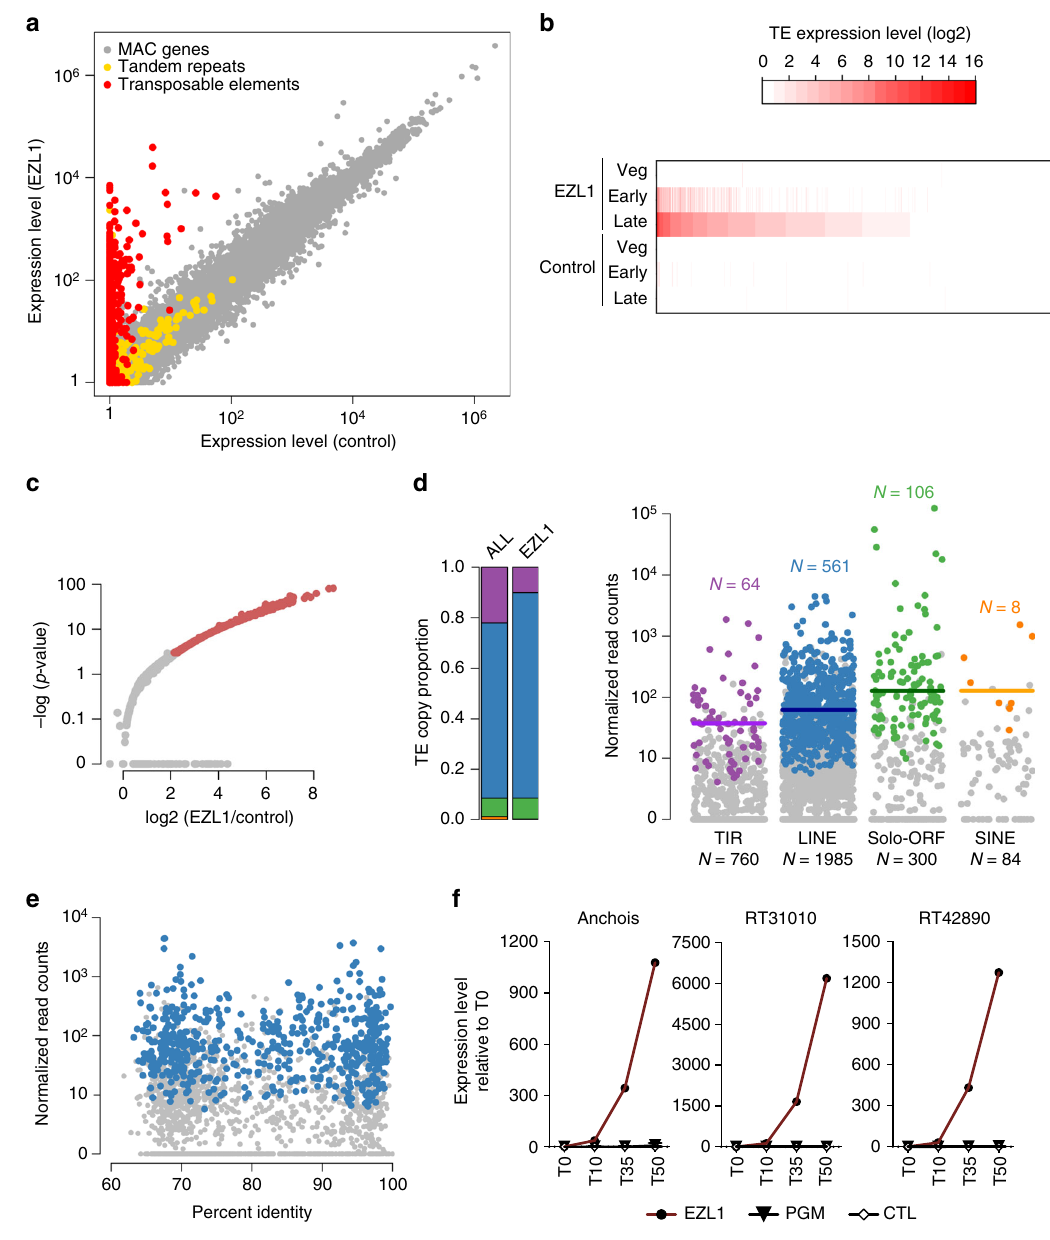
Fig. 4 Loss of H3K27me3 and H3K9me3 leads to transcriptional derepression of transposable elements. a Scatter plot of the mean normalized expression level as measured by RNA-seq for EZL1 and control samples of all elements ( n = 45,682; 41,533 genes in gray, 3129 TE copies in red, 1020 tandem repeats in yellow). The non-essential ICL7 gene was used as a RNAi control, because its silencing has no effect on sexual processes. b Heatmap of expression changes for TE copies at the three stages of the autogamy time-course (Veg, vegetative; Early; Late) in EZL1 RNAi and ICL7 (control) RNAi, ordered by EZL1 Late expression level. c Volcano plot of TE copy expression ( n = 3129) between EZL1 and ICL7 RNAi for the late stage. Red dots indicate signi fi cantly misregulation of 739 (23%) TE copies between EZL1 and ICL7 (control) RNAi (fold-change> 2 and p -value < 0.05). d Left, barplot showing the proportion of each TE family (TIR, purple; LINE, blue; solo-ORF, green; SINE, yellow) in all annotated TEs (ALL) and in the set of TEs whose expression is de-repressed upon EZL1 RNAi (EZL1). Right, expression of individual elements from four different TE families for the late developmental stage. Each dot represents a single element. The differentially expressed copies are shown in the same colors used for the barplot. The horizontal bar represents the median expression level of the differentially expressed copies. The total number of copies in each family is indicated below and the number of differentially expressed copies for each family above the jitter plots. e Scatter plot for the 1985 LINE copies, showing the relation between identity with the TE consensus and EZL1 expression level. Blue dots indicate the 561 differentially expressed LINE copies. f Expression of Anchois (TIR); RT31010 (LINE) and RT42890 (LINE) transposable elements at different time-points during development (T0; T10; T35; T50) upon PGM , EZL1 , or control ( ICL7 ) RNAi as measured by RT-qPCR. Values were normalized to GAPDH and are expressed as the fold-change to T0 (corresponds to the onset of sexual events) for each autogamy time-course experiment. Data represent the mean expression from two biological replicates for PGM RNAi. Data source are provided as a Source Data fi